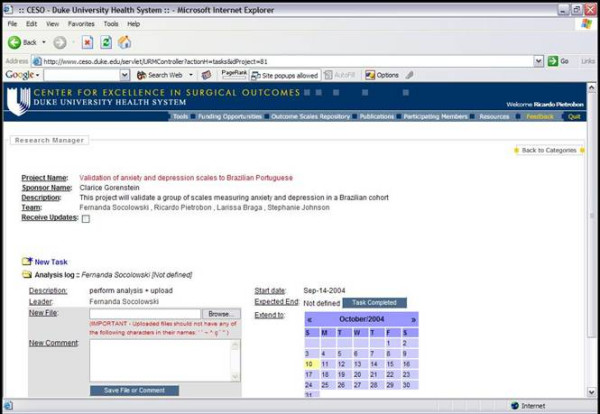
Research Manager